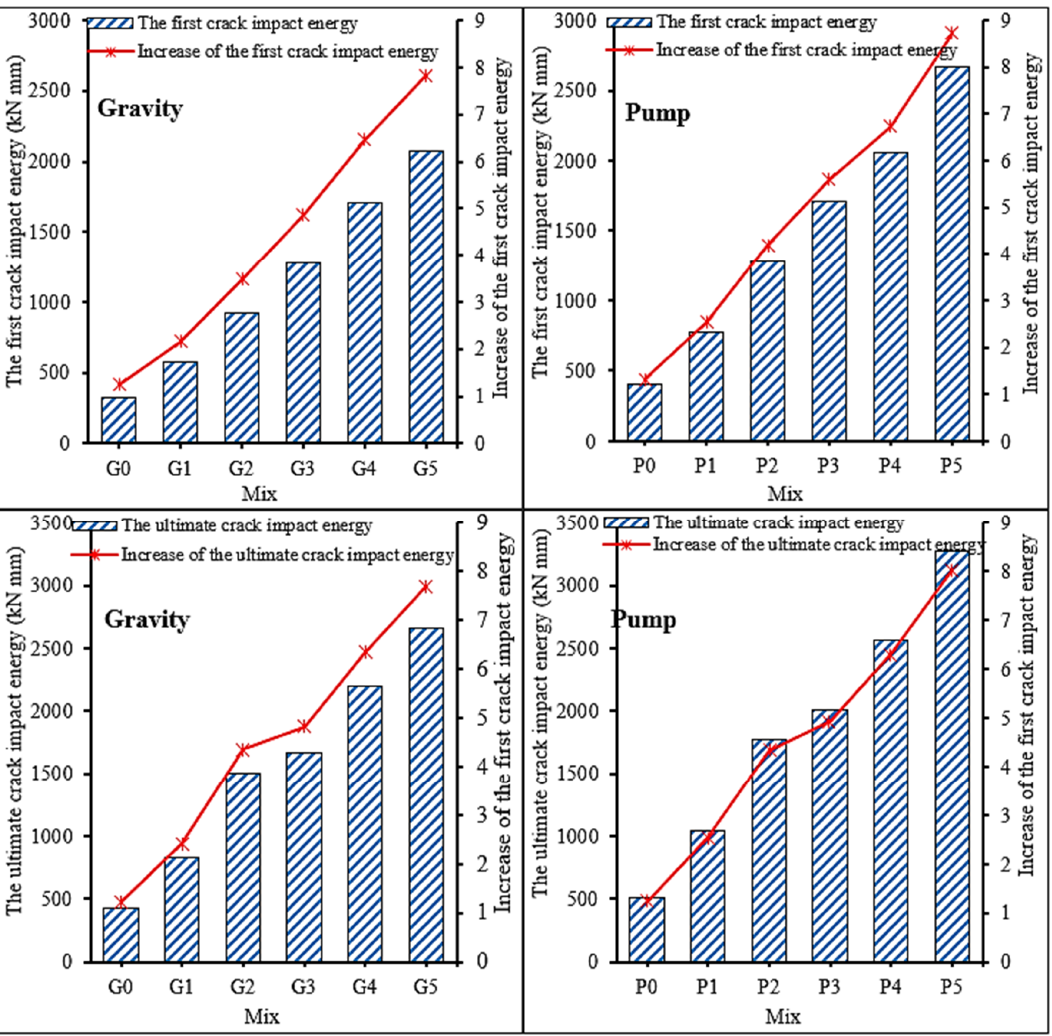
Figure 8. Impact energy of PAFRC specimens for gravity and pumping methods.